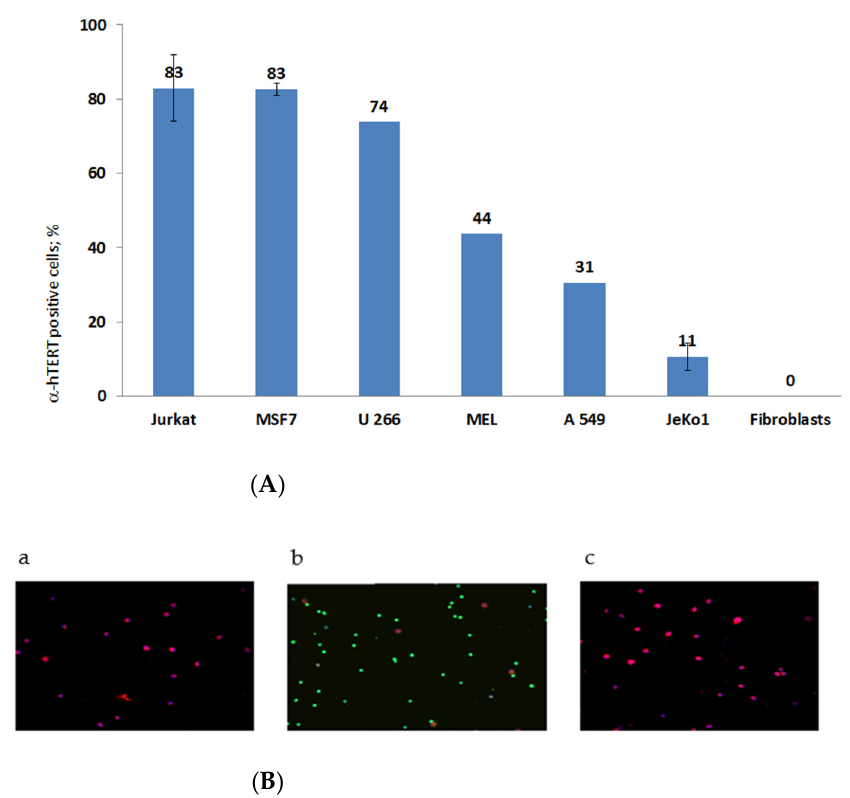
Figure 1. ( A ). flow cytometry analysis. Cells were grown in standard conditions according to the ATCC recommendations. The binding of the α -hTERT mAb to the cells was detected by flow cy- tometry using a secondary labeled antibody as described in the Materials and Methods section.